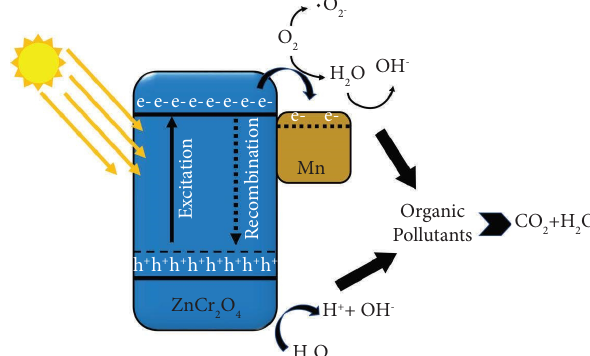
Scheme 2: Photocatalytic activity mechanism of Mn-doped ZnCr